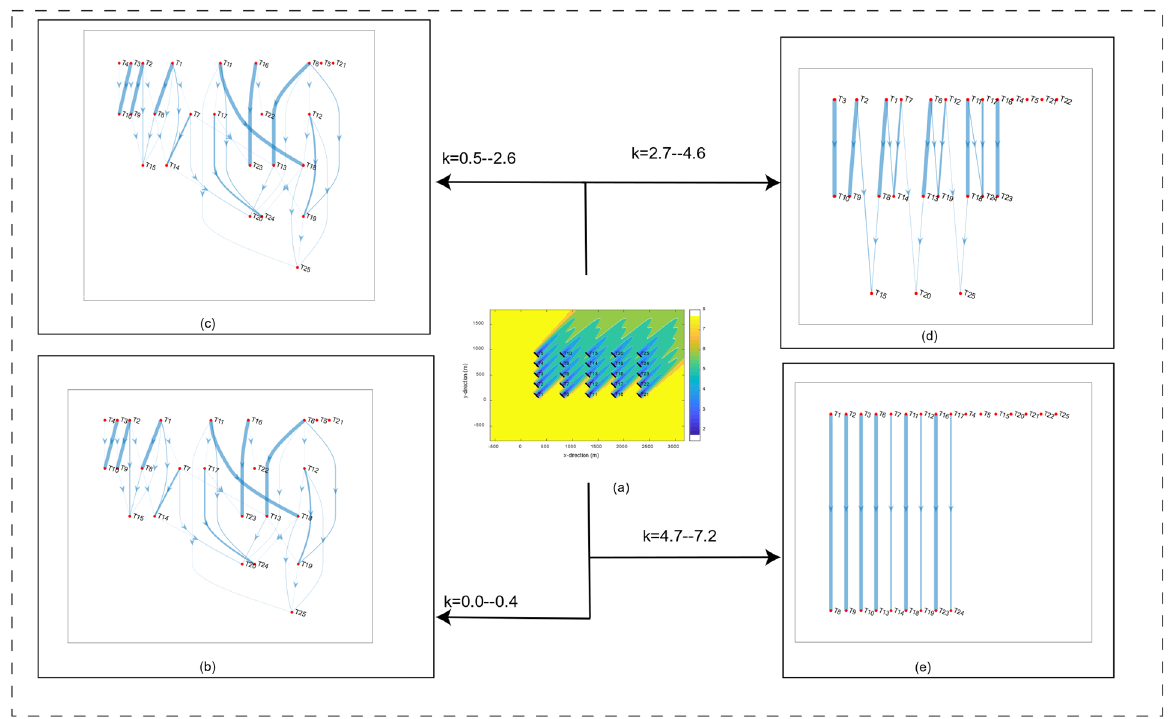
Figure 6. The process of adaptive pruning wake digraph method with varying k for the wake digraph ( ε = 0.0122 ) with wind direction ϕ = 45 ◦ : ( a ) wake field; ( b – e ) pruned wake digraph G p with different k . Table 1. The relationship of subsets and shared turbines (ST) with different 𝑘 .